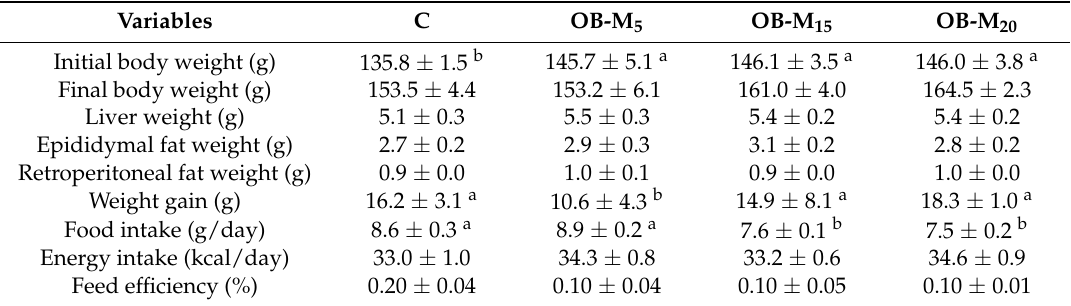
Table 3. Body and tissue weights, weight gain, and energy consumption of the eight-week experimental